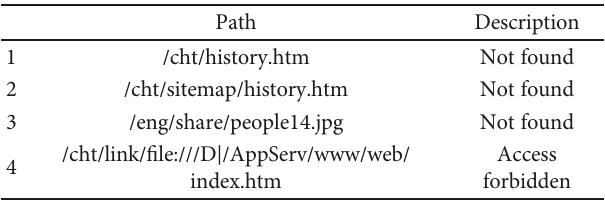
Table 9: Test result of the emulation mode with time (errors and exceptions).